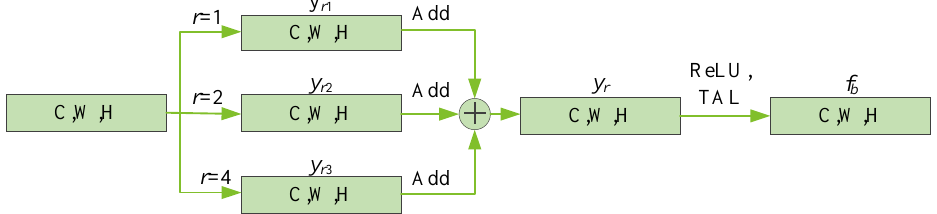
Figure 2. Dilated convolution module with exponentially increasing dilated rate ( r = 1, 2, 4), stride = 1, kernel size = 3.